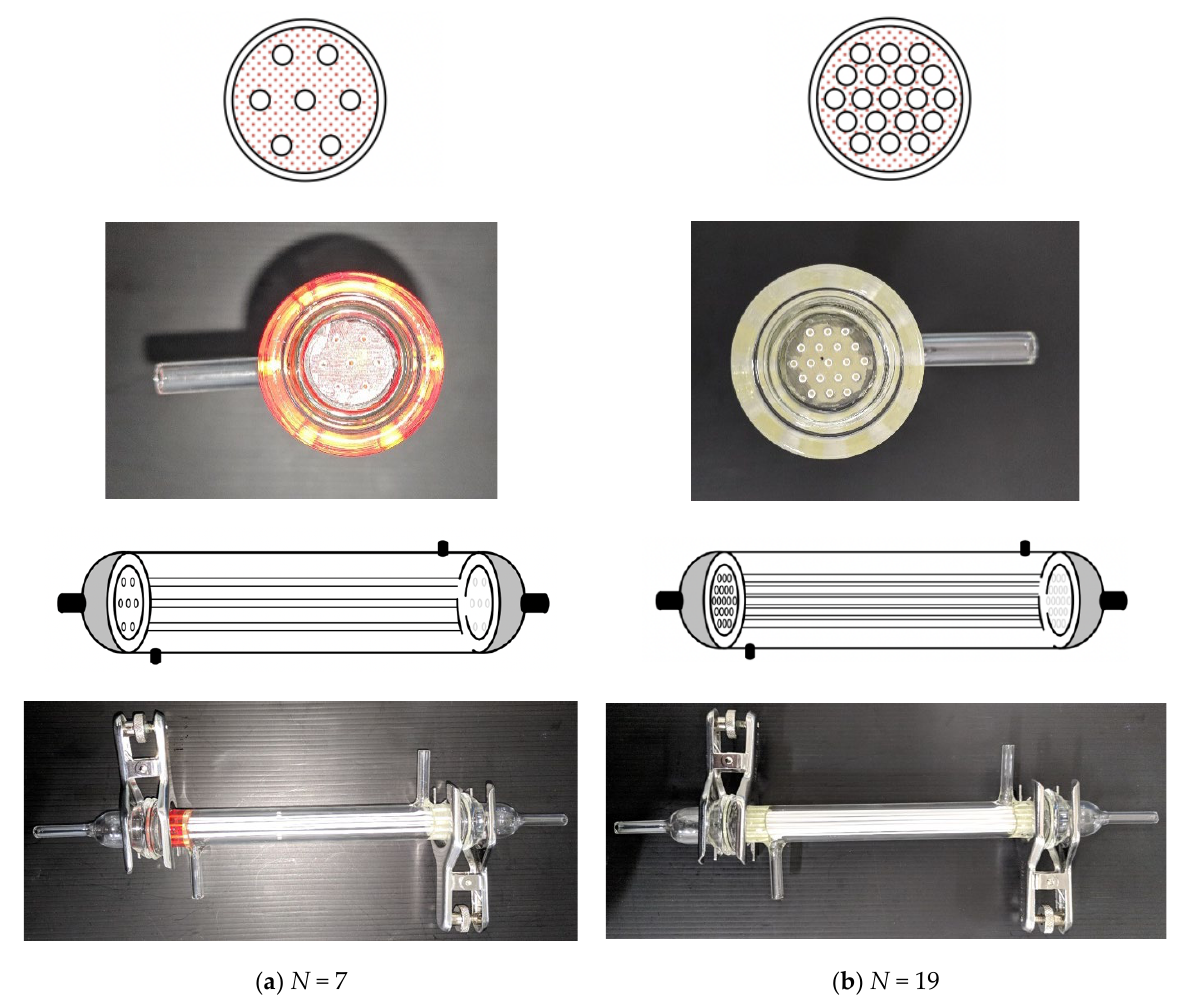
Figure 5. Details of the module configuration with the pinch caps at both ends.